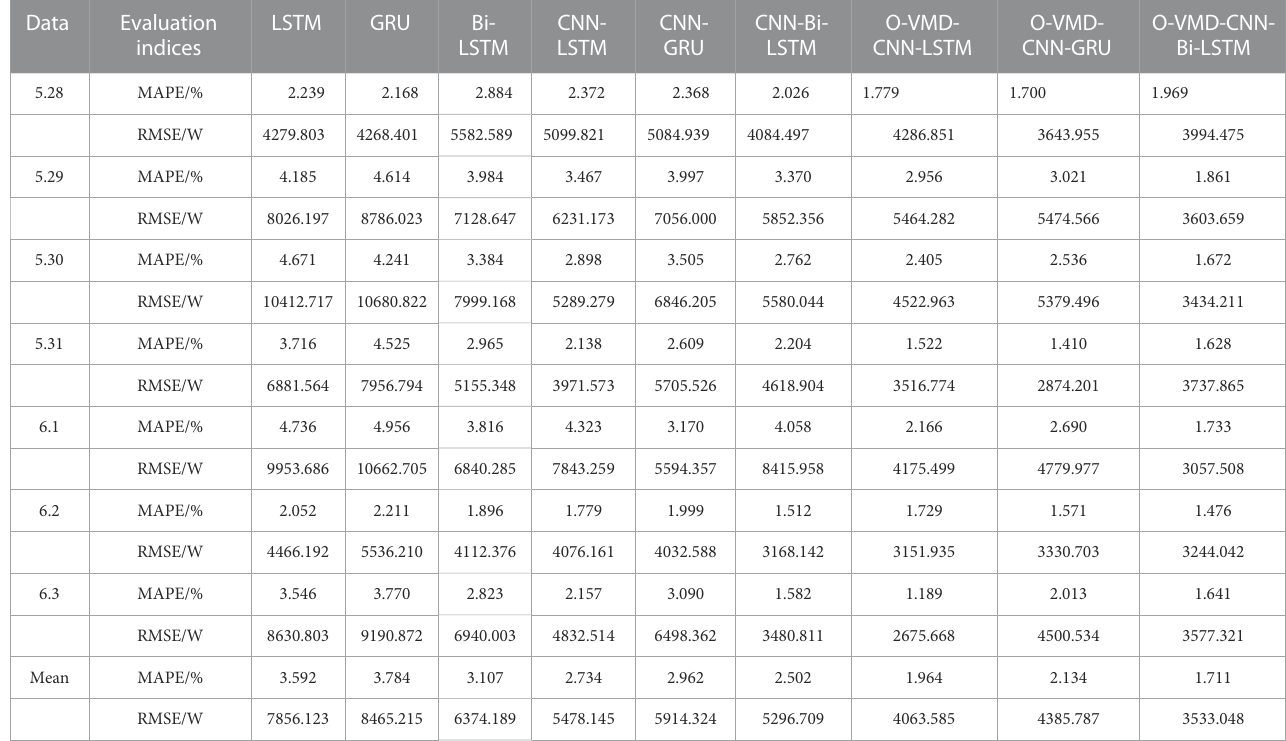
TABLE 2 Statistical results of load forecasting of multi models for a week.